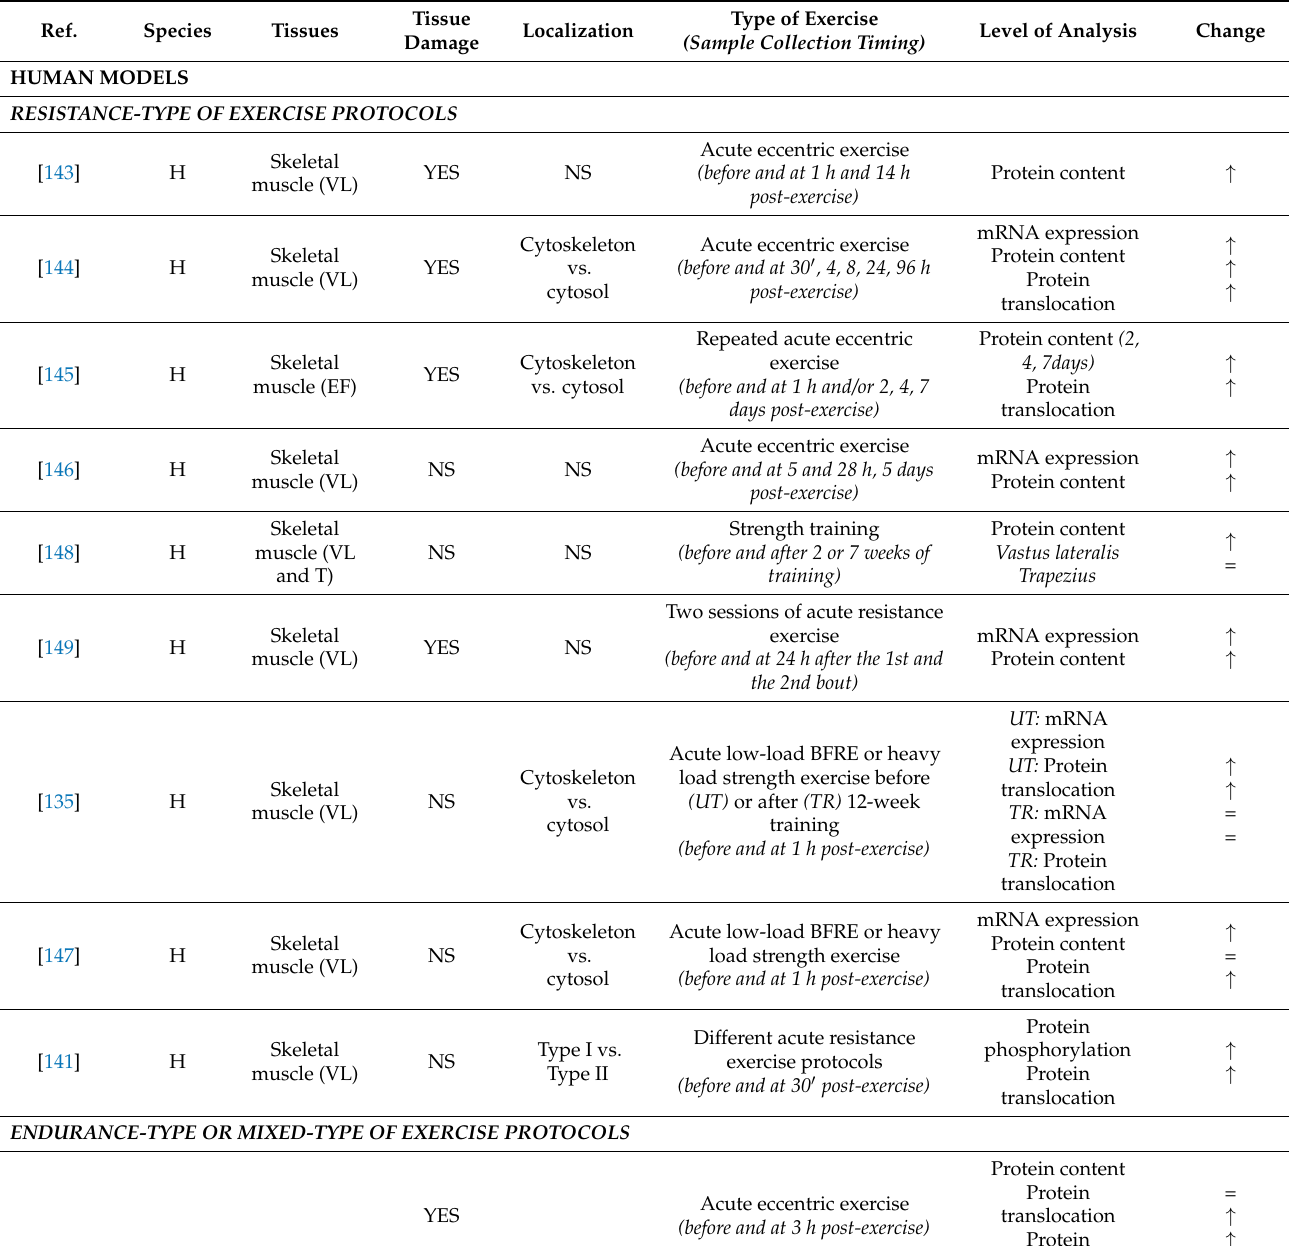
Table 4. Exercise-induced modulation of HSPB5 in skeletal and cardiac muscle.